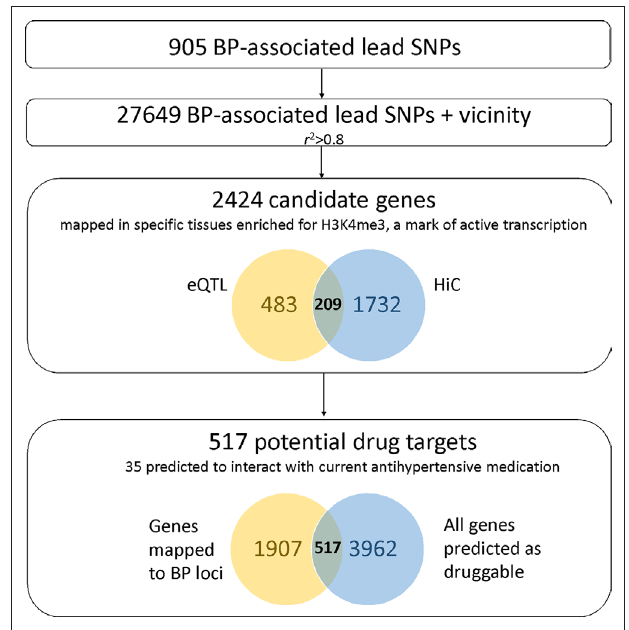
FiGuRe 4 | Diagram illustrating the results of our integrative